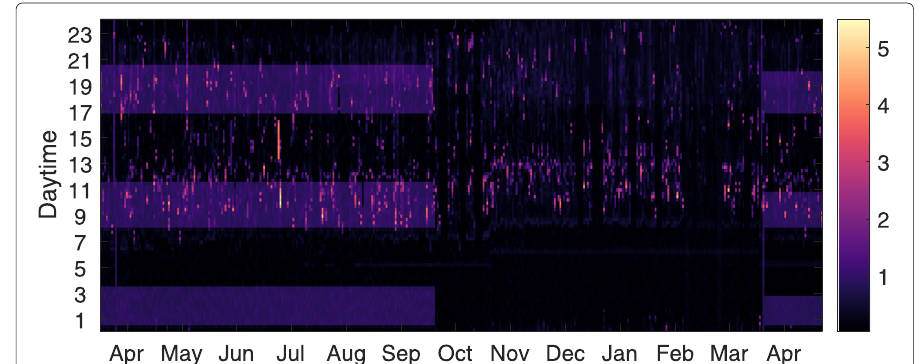
Fig. 1 Heatmap showing the load [kW] of a household with a pool. This household’s pool pump runs regularly so that the pool features of (Burkhart et al. 2018) can be extracted rather easily by detecting the rectangular shaped areas